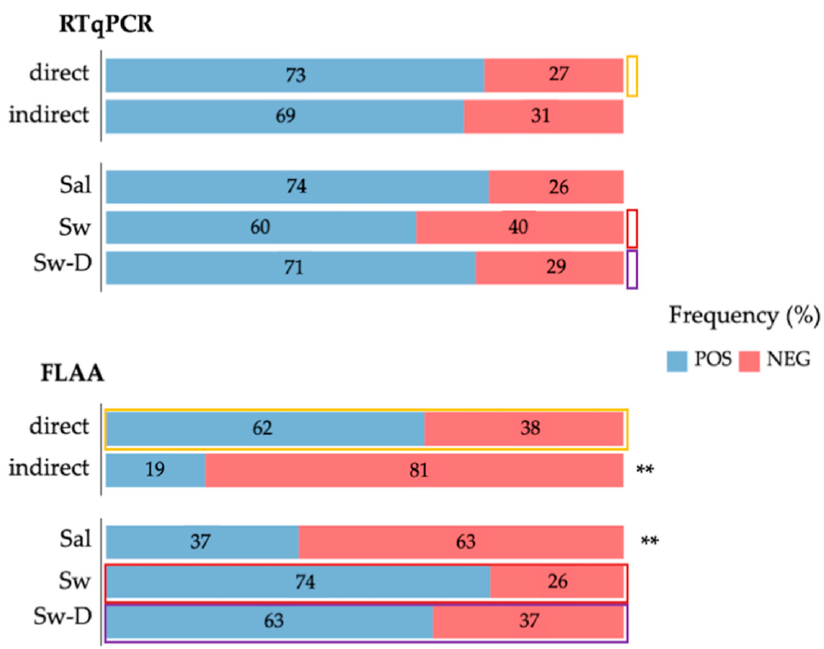
Figure 4. Frequency plots for positive and negative samples percentage divided by protocol and sample types. Yellow, red and purple rectangles represent proportions that should be the same as RTqPCR. ** represent most varying frequency ratios.